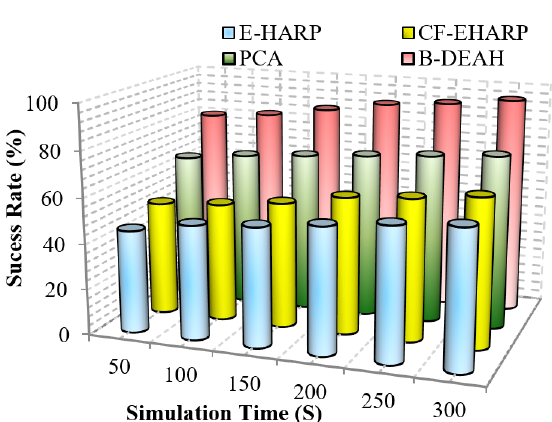
Figure 18. Success rate vs. simulation time (emergency packets).